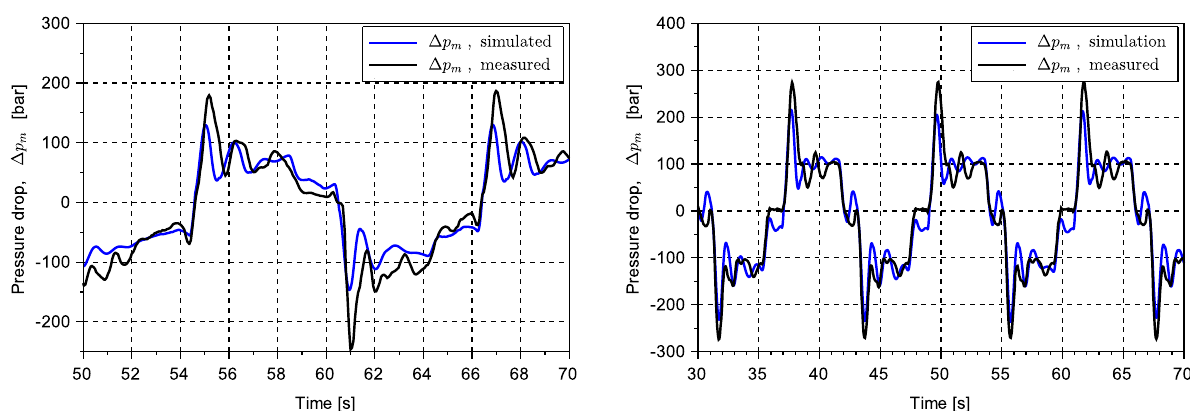
Figure 21: Measured and simulated pressure drop across the motors (active side), with winch speed according to Fig. 20.